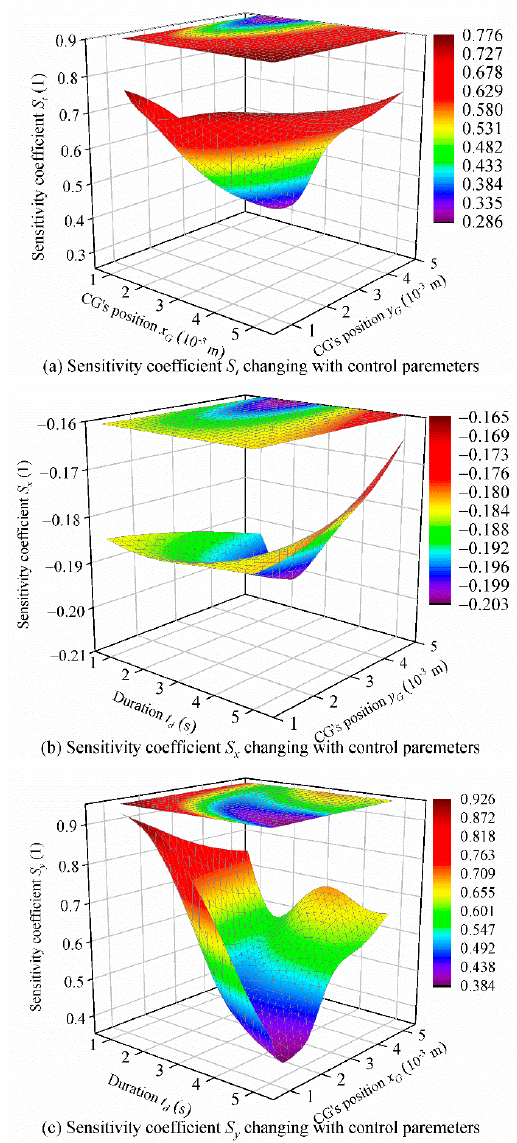
Figure 11. Sensitivity coefficients of the DTUG.